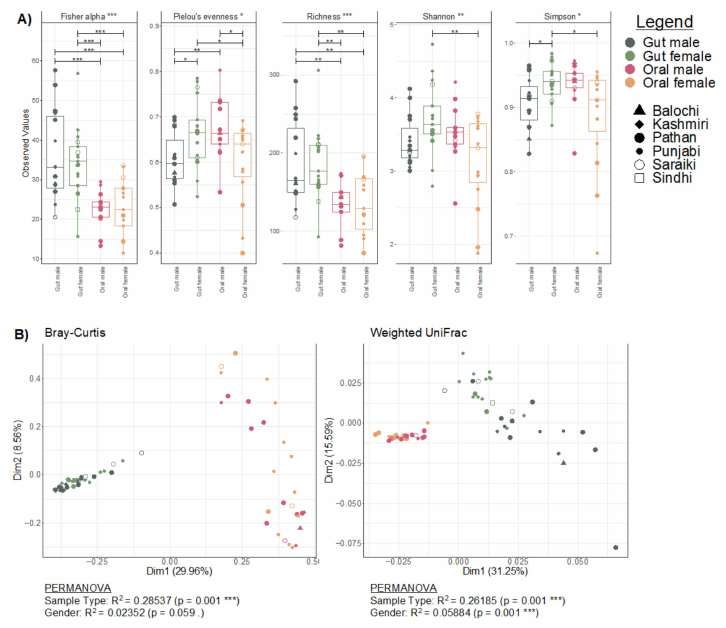
Figure 1. Diversity estimates. ( A ) Commonly used alpha diversity indices with overall significance considering all four cohorts (gut male, gut female, oral male, and oral female) represented in the strip legends whilst pair-wise differences if significant (based on ANOVA) are represented by lines connecting two categories. ( B ) Principal coordinate analysis (PCoA) using different several dissimi- larity indices (Bray-Curtis and weighted UniFrac) where ellipses were drawn using 95% confidence intervals based on the standard error of ordination points for a given category. Beneath each figure are the R 2 values (along with p -values if significant) calculated from PERMANOVA. The significances are shown with p < 0.1, * p < 0.05, ** p < 0.01, or *** p < 0.001.